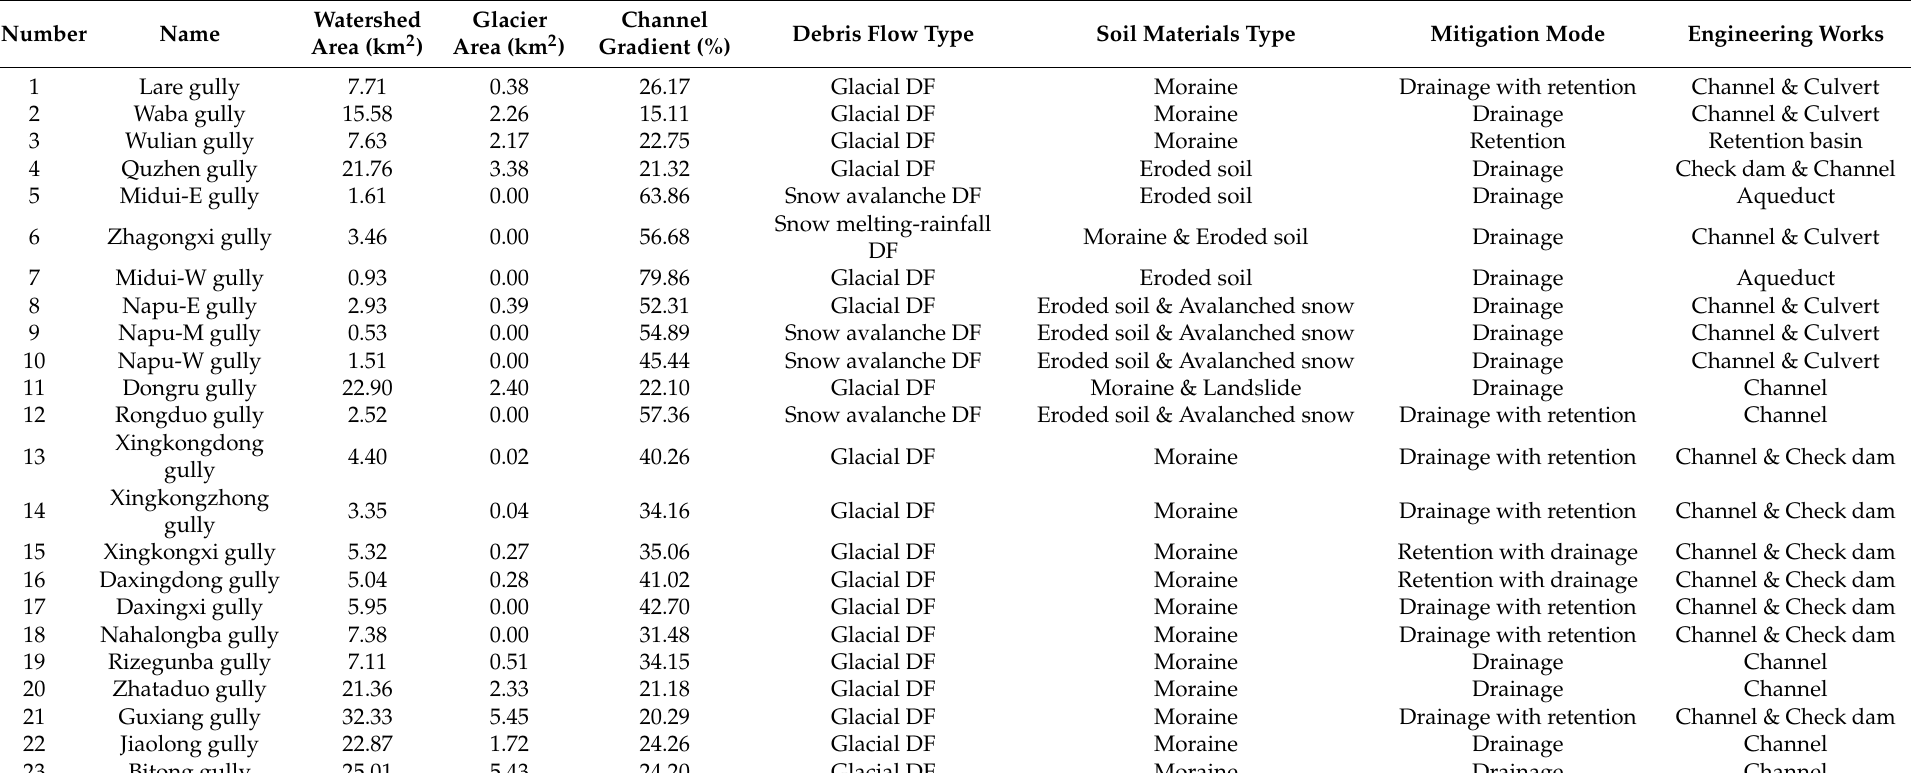
Table 2. The investigation data of mitigation engineering of glacial debris flow in the